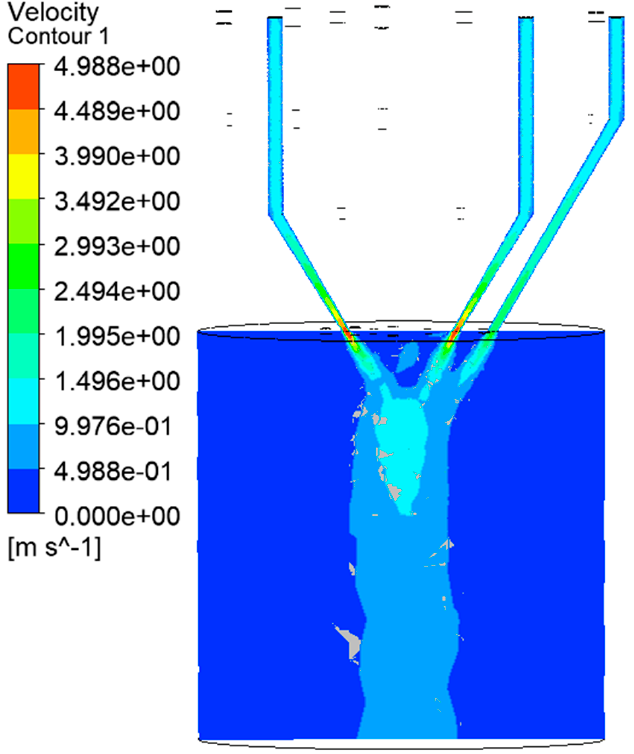
Figure 7. Powder flow velocity diagram of inner and outer rings coordination work.